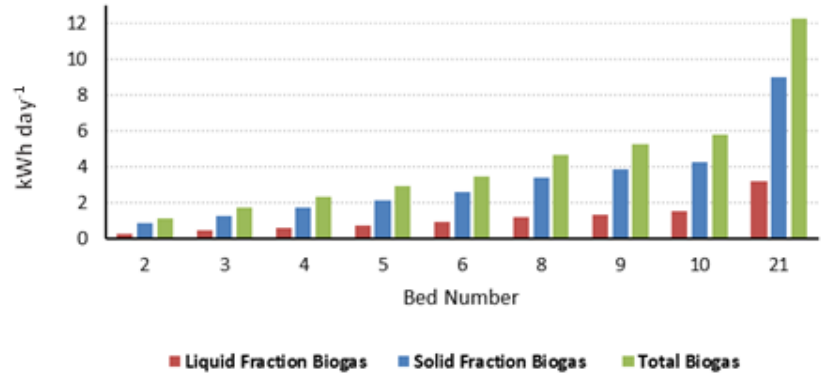
Figure 5. Biogas generation per rural house.